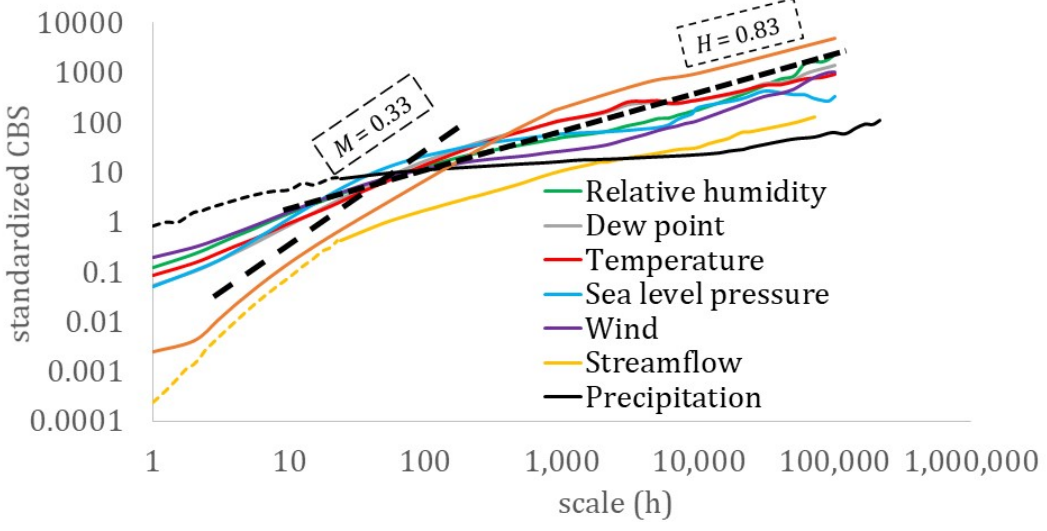
Figure 13. The mean climacospectrum for the key hydrological-cycle processes and the grid-turbulence process accustomed for illustration to a 25 μ s-scale rather than to the hourly scale. Dashed and continuous lines in streamflow and precipitation correspond to the hourly and daily stations.